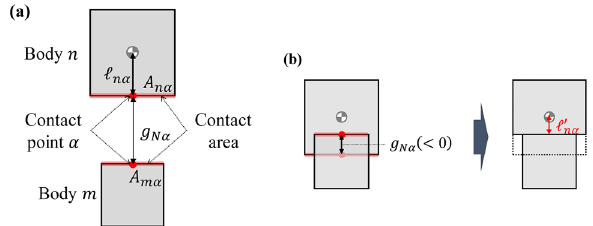
Fig. 5 a Definition of contact point and surface; b Definition of plastic